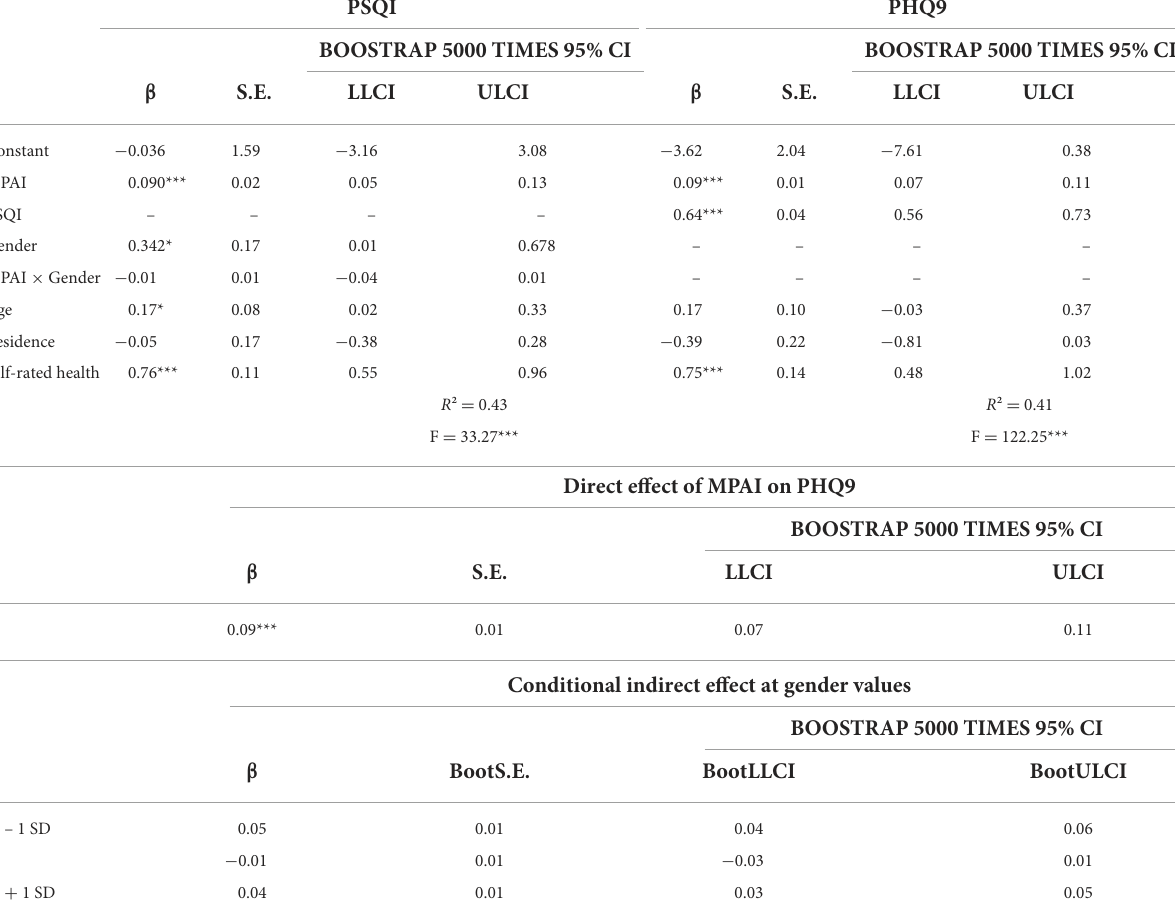
TABLE 4 Testing the moderated mediation effect of mobile phone addiction on depression